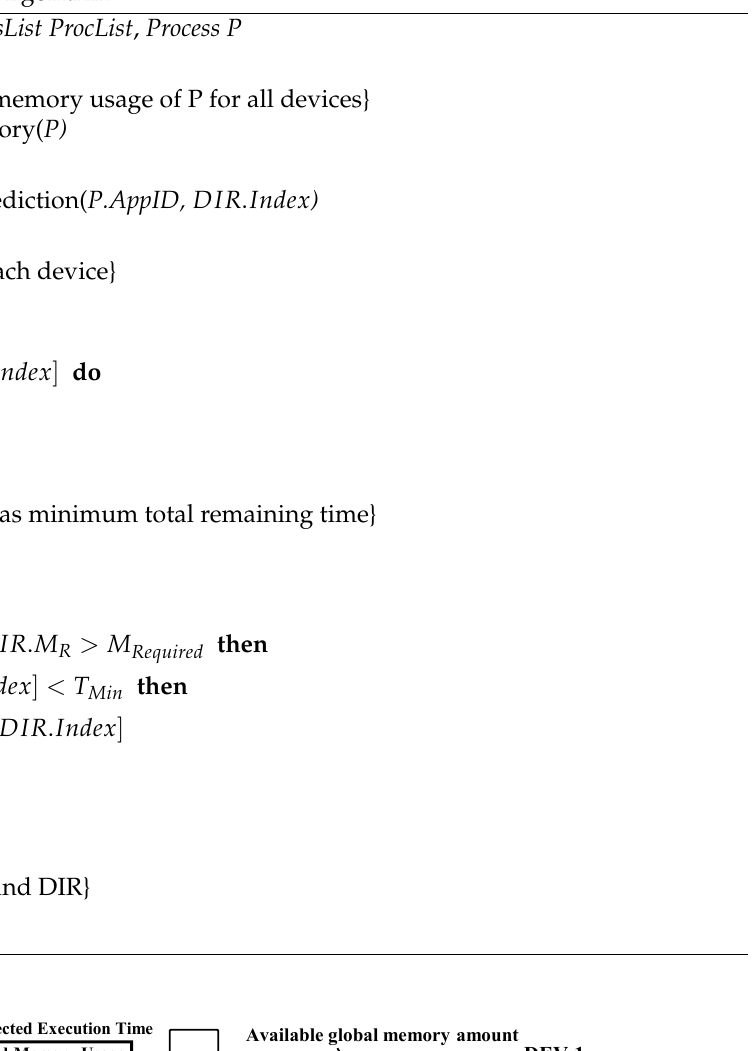
Algorithm 1 Process Allocation Algorithm.